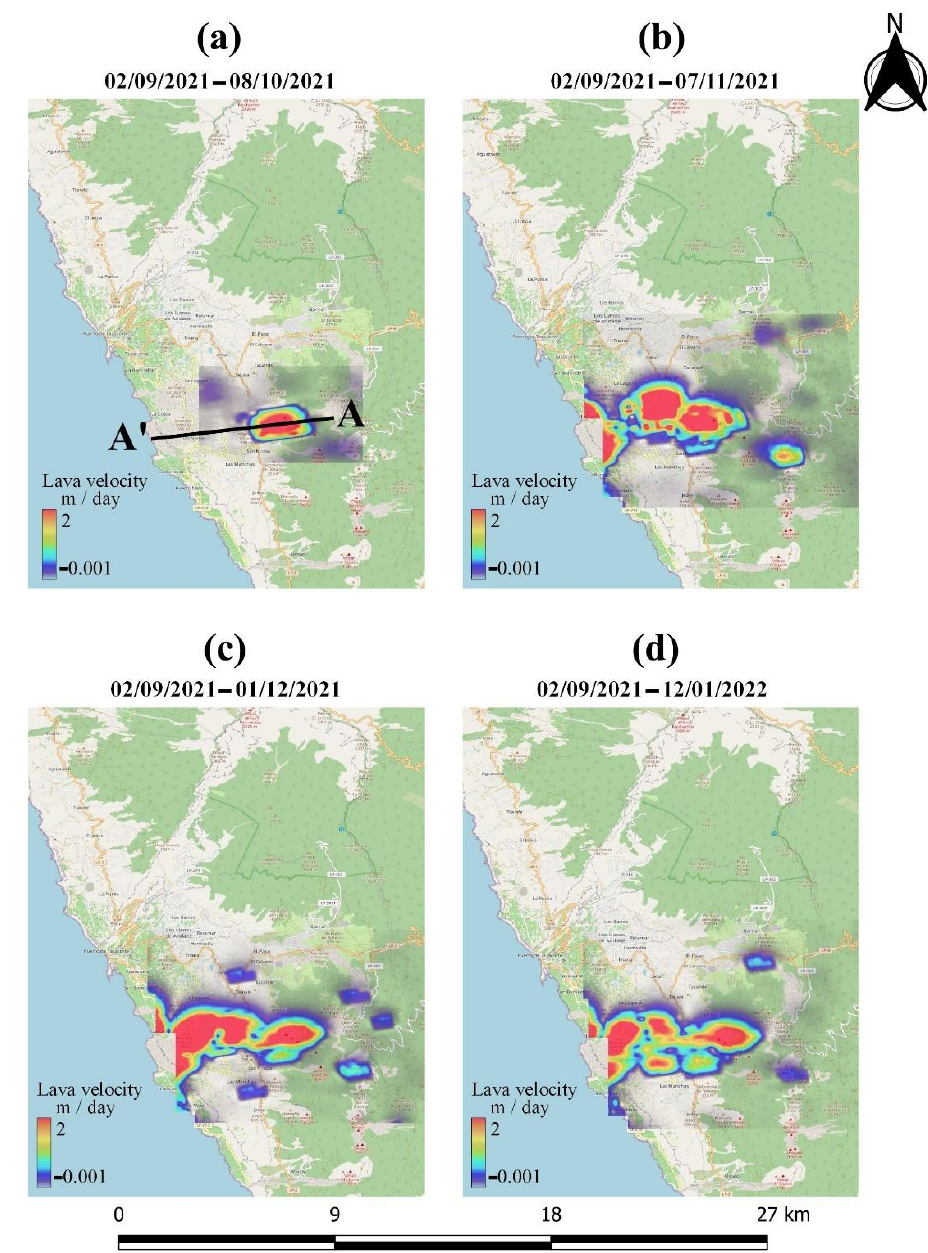
Figure 10. Lava flow evolution, obtained by processing the Sentinel-1 ascending data through offset tracking.